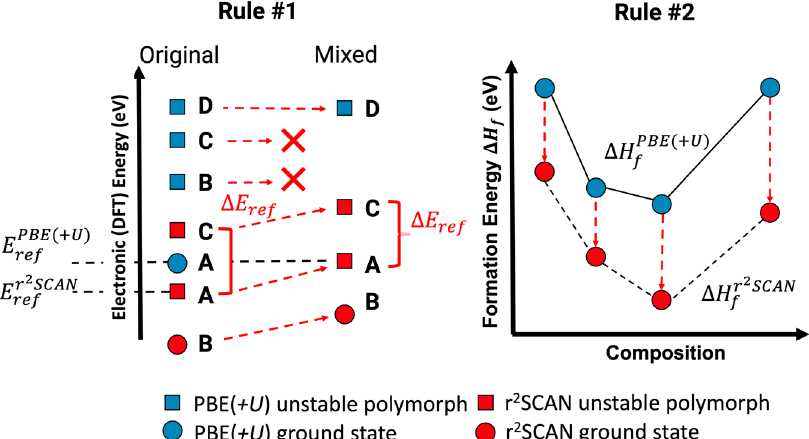
Fig. 1 Rules for mixing PBE( + U ) (blue) and r 2 SCAN (red) energies onto a single phase diagram. Left r 2 SCAN energies can be placed onto a PBE( + U ) hull by referencing them to the r 2 SCAN energy of the PBE( + U ) ground state via Δ E ref . In the diagram, A, B, C, and D represent different polymorphs at a single composition, and polymorph A is the PBE( + U ) ground state. E PBE þð U Þ